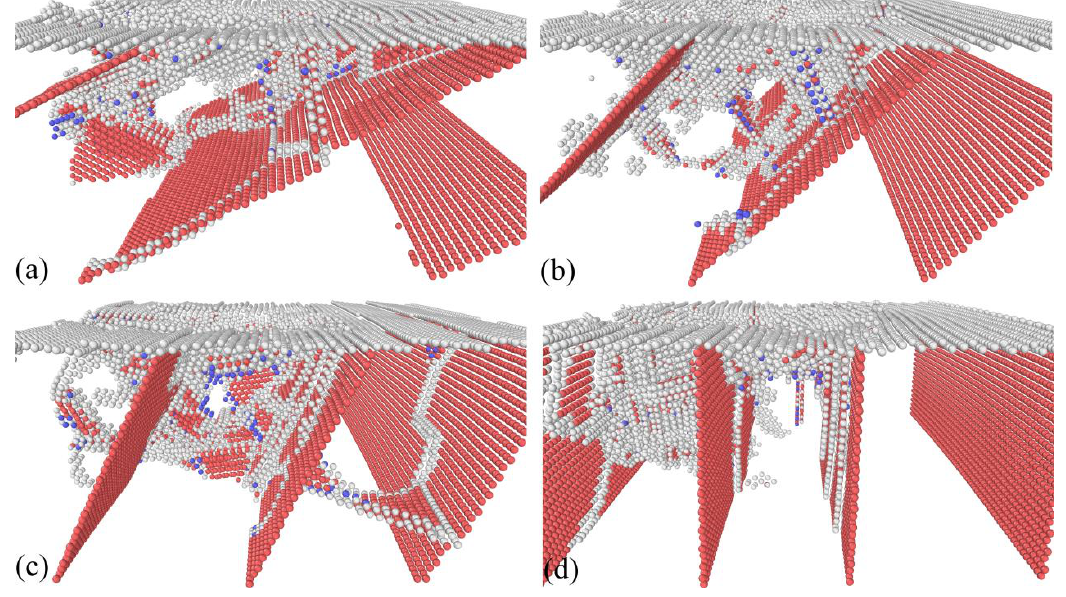
Figure 7. Representative dislocation–TB interactions. Inclination angle: ( a ) 26°; ( b ) 45°; ( c ) 64°; and ( d ) 90°. Atoms are colored according to their CNA values, and perfect FCC atoms are not shown.